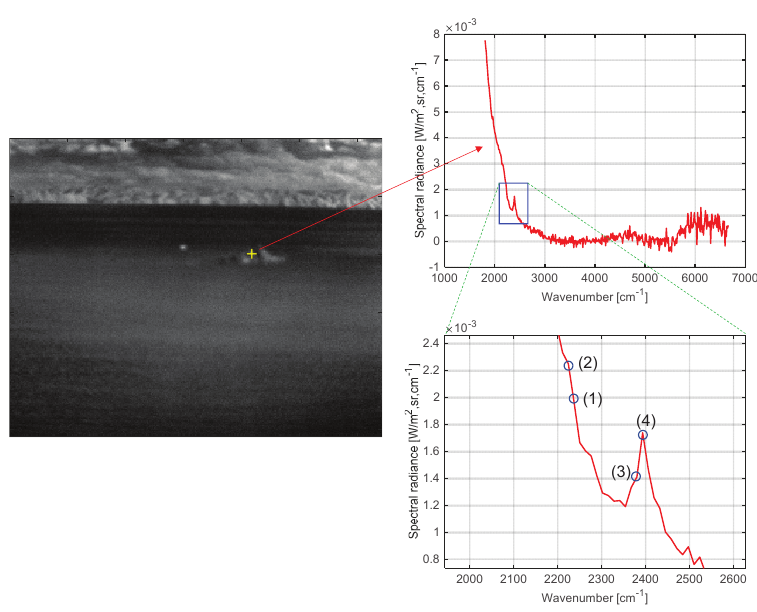
Figure 7. Spectral profile of a remote ship’s plume with the probed band positions: first spike: (1) and (2); second spike: (3) and(4).